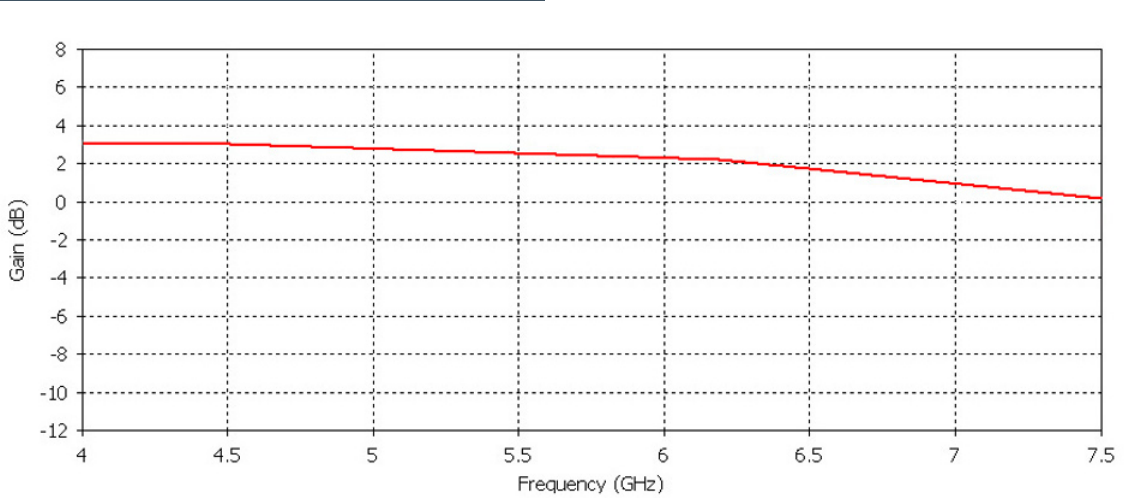
Figure 14. Variation of gain as a function of frequency for proposed